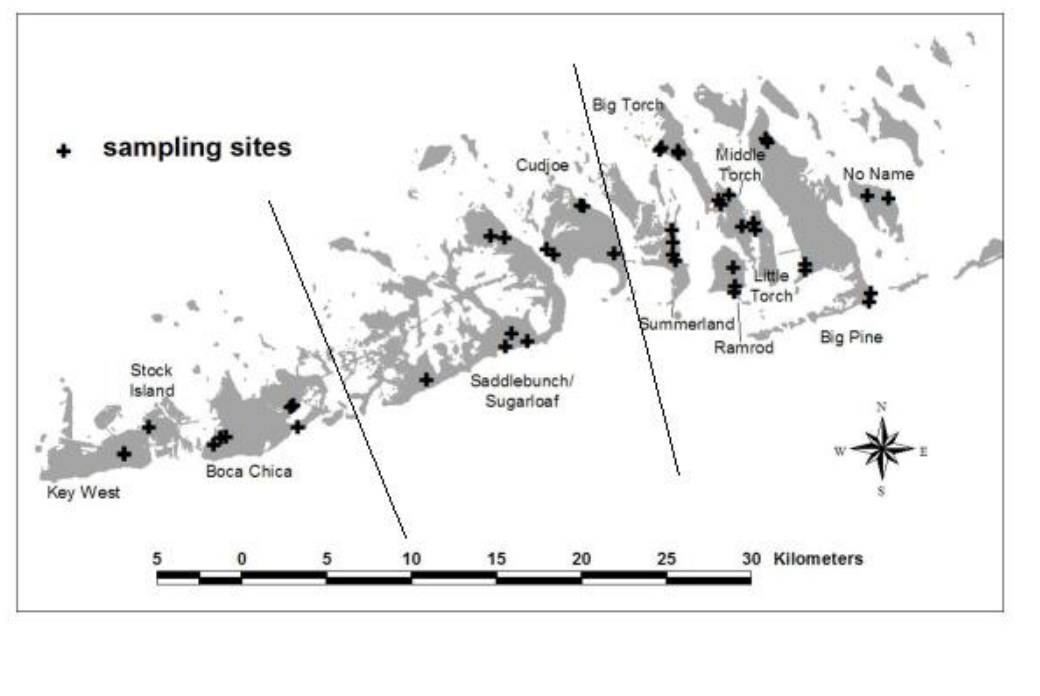
Fig. 1. Map of the Lower Florida Keys showing sampling locations. Lines between Keys indicate groupings of Keys used in